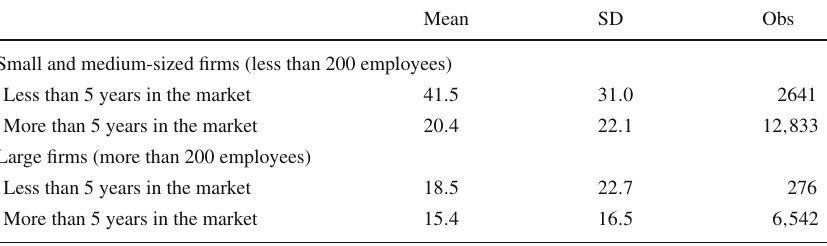
Table 3 Proportion of temporary workers by firm’s age and size Mean SD Obs Small and medium-sized firms (less than 200